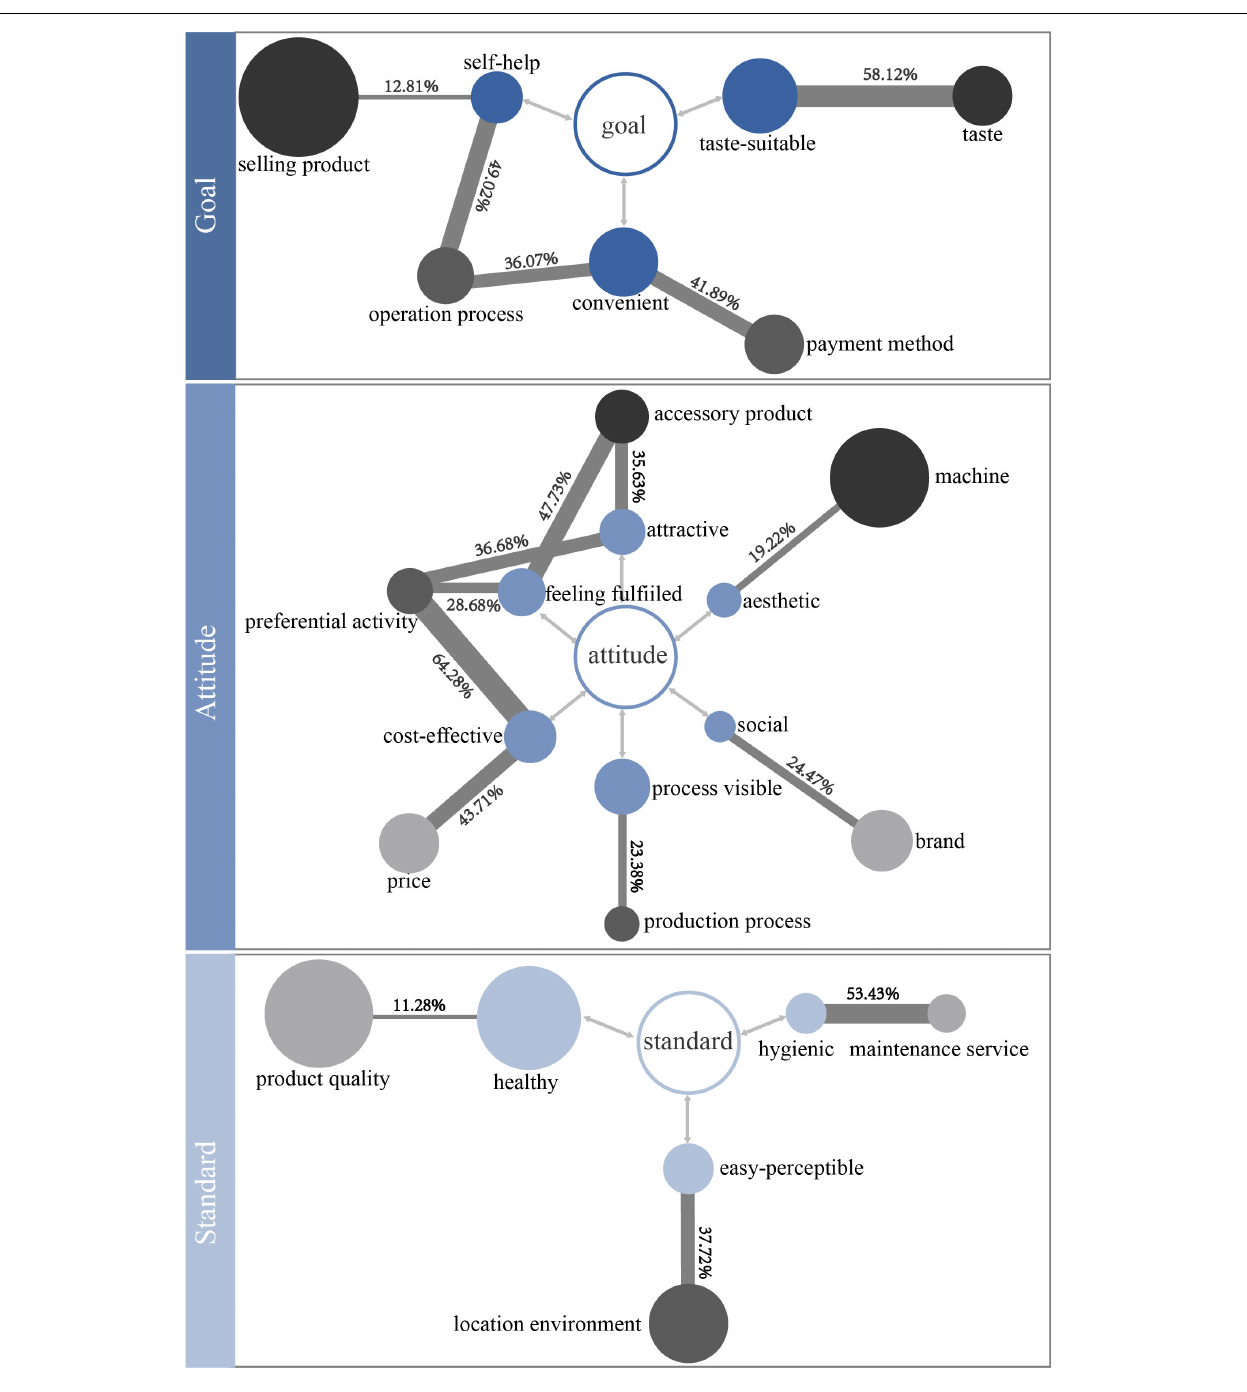
when the “user concern–product stimulus” pairs are located in zone 3, d < 0, the user concerns are already satisfied and the positive emotions are obvious, so the feasibility of subsequent improvements is relatively low. When the pairs are located in zone 1 or 2, d > 0, the user concerns are not satisfied, so the